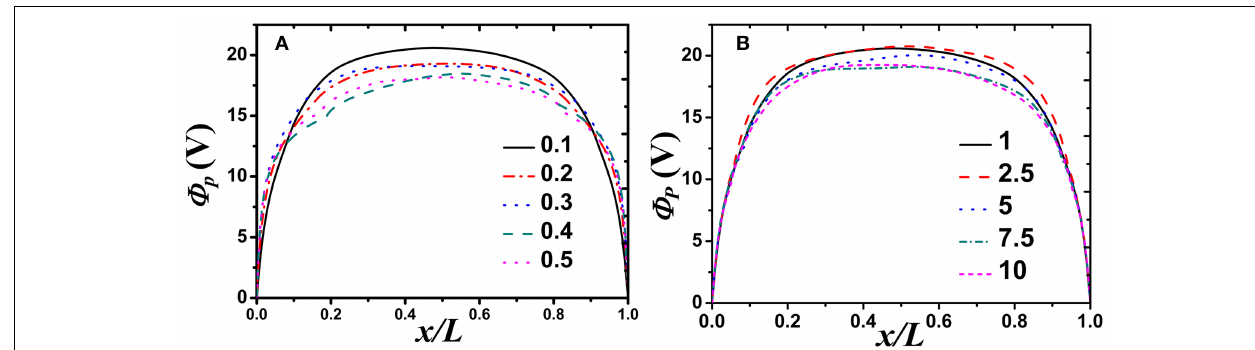
FIGURE 2 | Plasma space potential at different (A) lengths (in m) and (B) pressure (in